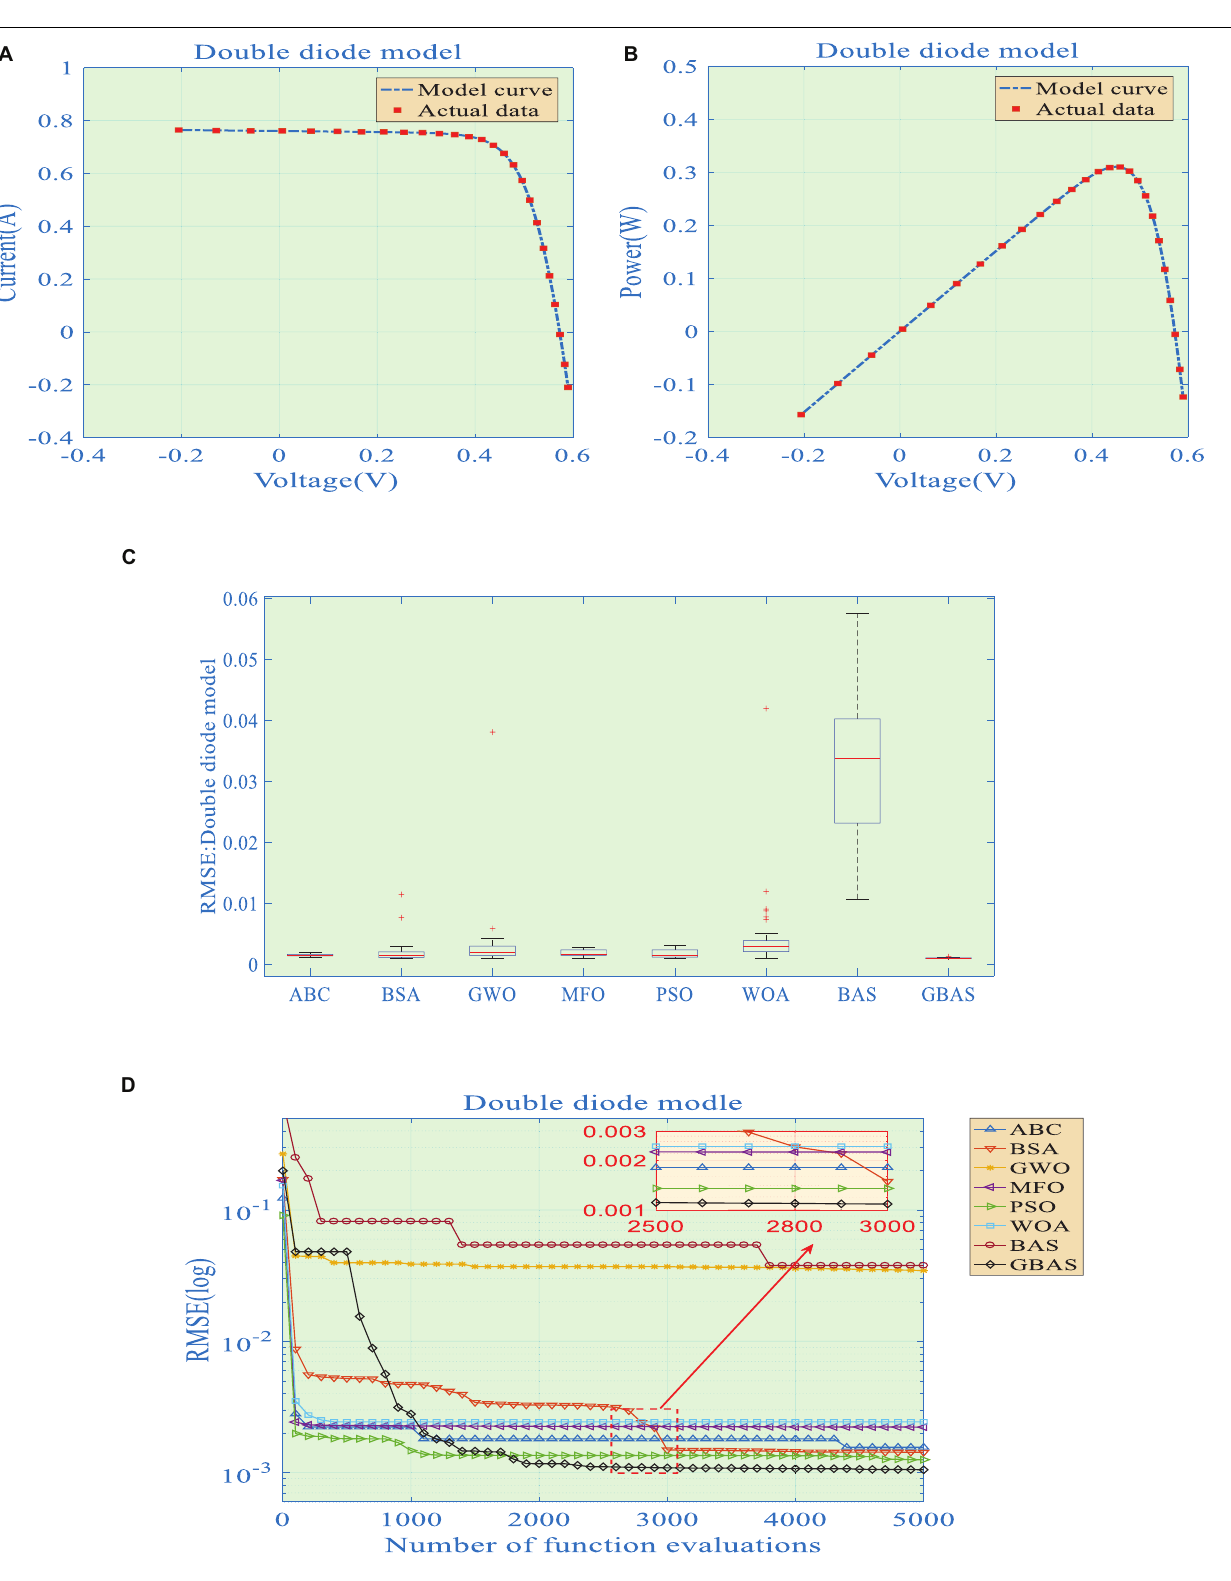
FIGURE 3 | Identification results obtained by grouped beetle antennae search (GBAS) algorithm for double diode model (DDM): (A) I-V curve; (B) P-V curve; (C) boxplot of RMSE; (D) convergence graph.